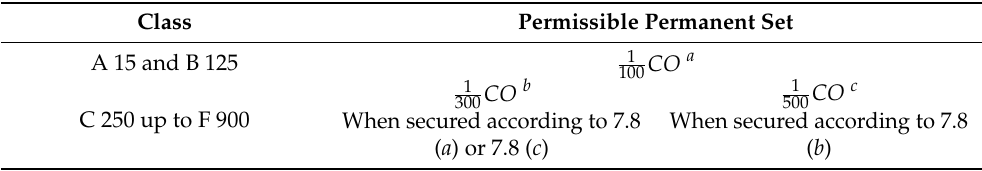
Table 3. Permissible permanent set according to EN